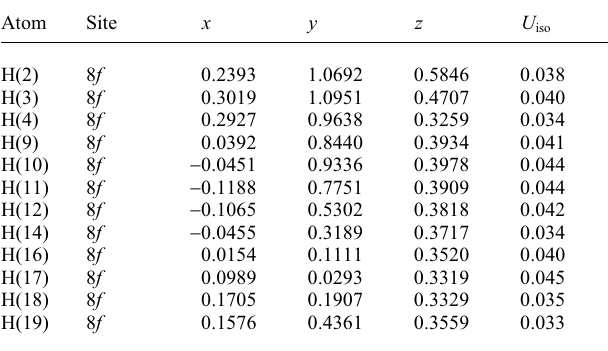
Table 2. Atomic coordinates and displacement parameters (in Å 2 )